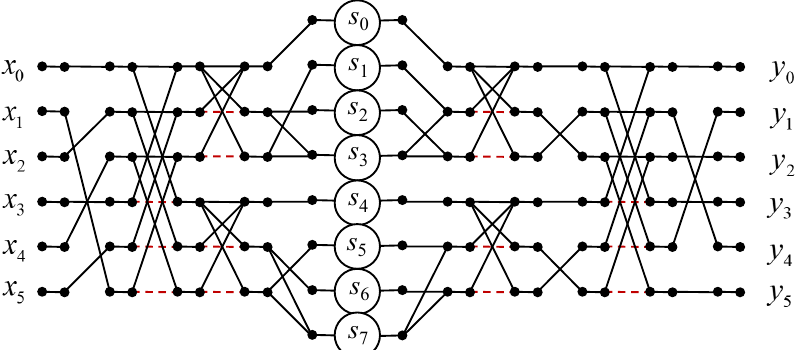
Figure 5. Algorithmic structure of the processing core for the computation of the 6-point circular